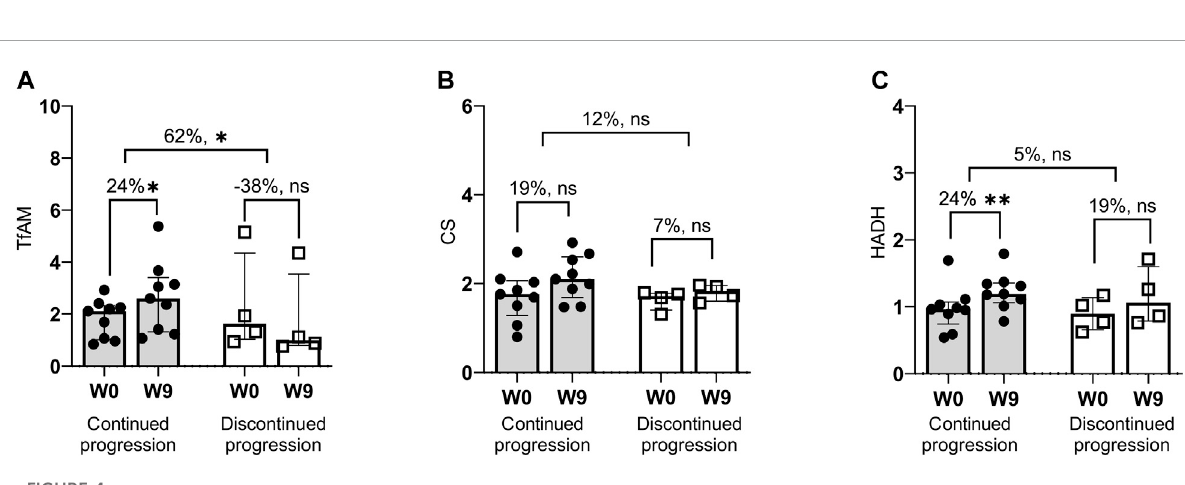
FIGURE 4 Changes in mitochondrial (oxidative) enzymes. Median values with error bars (75% interquartile range). TfAM = mitochondrial transcription factor A (A) ; CS, citrate synthase (B) ; HADH = hydroxyacyl-coenzyme A dehydrogenase (C) , W, Week. * p < 0.05, ** p <